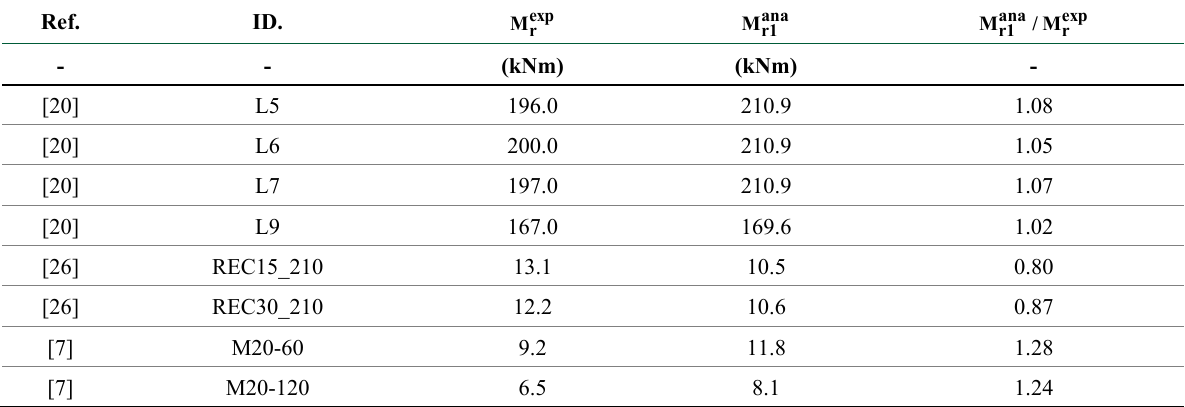
Table 4. Analytical and experimental results for bending moment